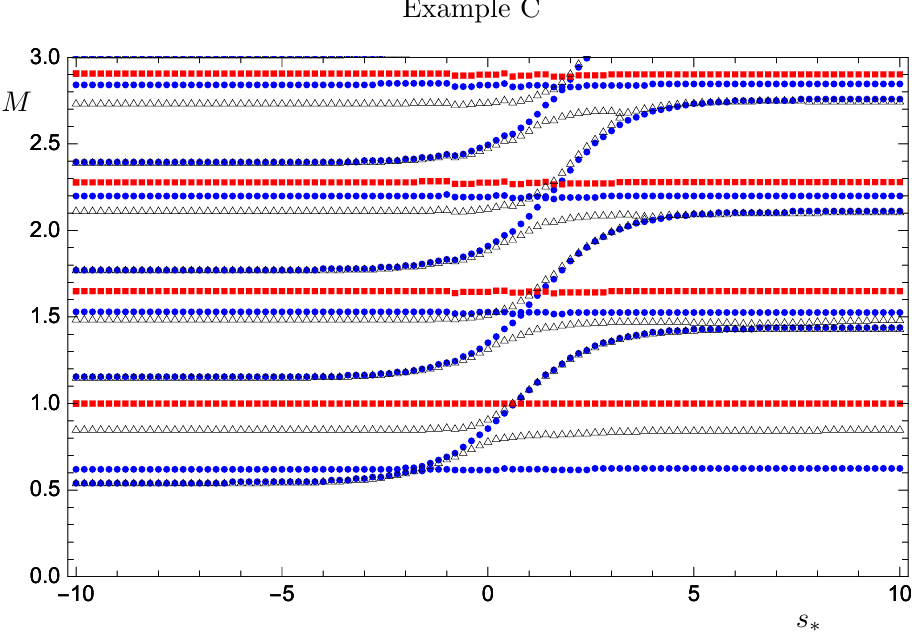
p Figure 4 . Masses M = (cid:0) q 2 of modes in the circle reduction of Romans theory, as a function of the parameter s (cid:3) . All masses are expressed in units of the mass of the lightest tensor mode. The (red) squares represent the tensor modes, the (blue) circles are the scalar modes, computed with the complete, gauge-invariant variables, while the (black) triangles are the scalar modes computed by making use of the probe approximation. We notice that in probe approximation, and for large values of s (cid:3) , two of the towers of scalar state become so close to degenerate that in our numerical study we could not resolve them, and they are represented by just one set of points. In the numerical calculations (cid:26) 1 = 0 : 001 and (cid:26) 2 =